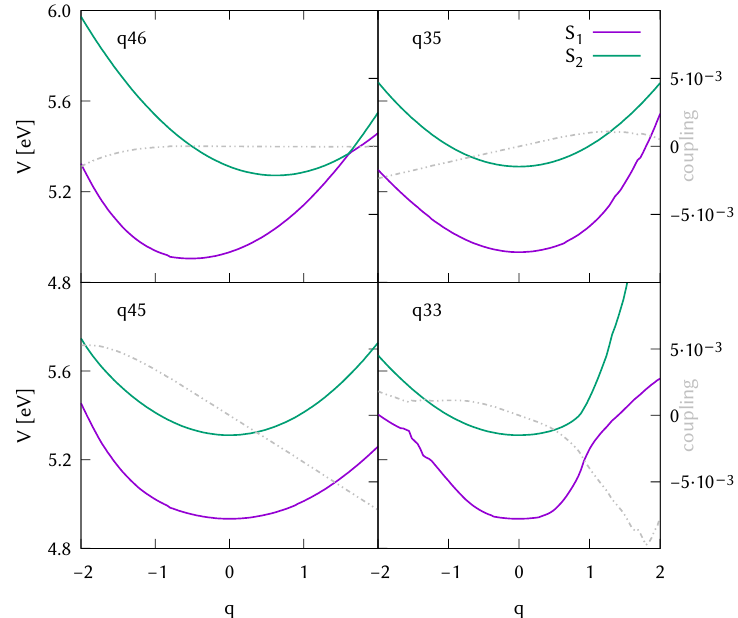
Figure 5. Potential energy surfaces along the four most important normal modes: symmetric C=C stretching and three N-Me 2 tilting modes plotted from the database of 601 ab initio points resulting from the TDA-wB97X-D3/cc-pVDZ DD-vMCG dynamics in the gas phase started from the state L a (S 2 ). The diabatic coupling along those modes is plotted in grey for